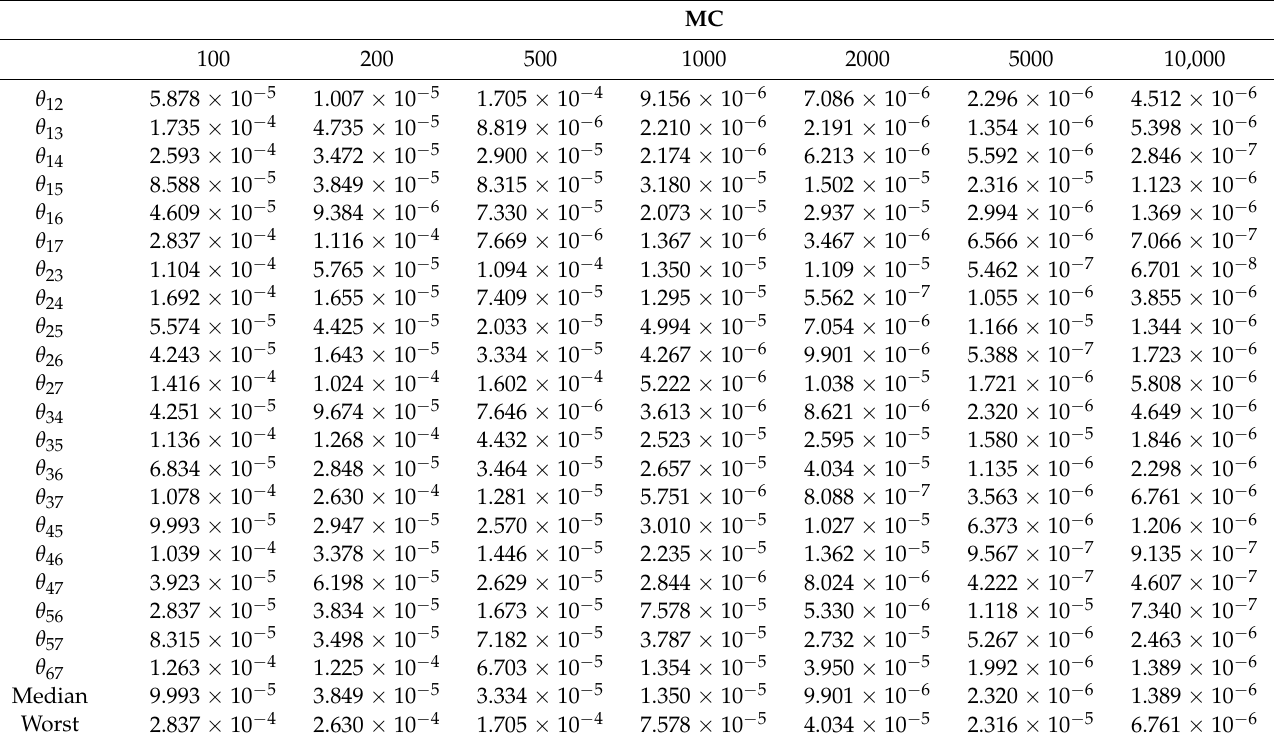
Table A1. The difference between PSIIRC absorption spectra calculated with different numbers of MCM realizations